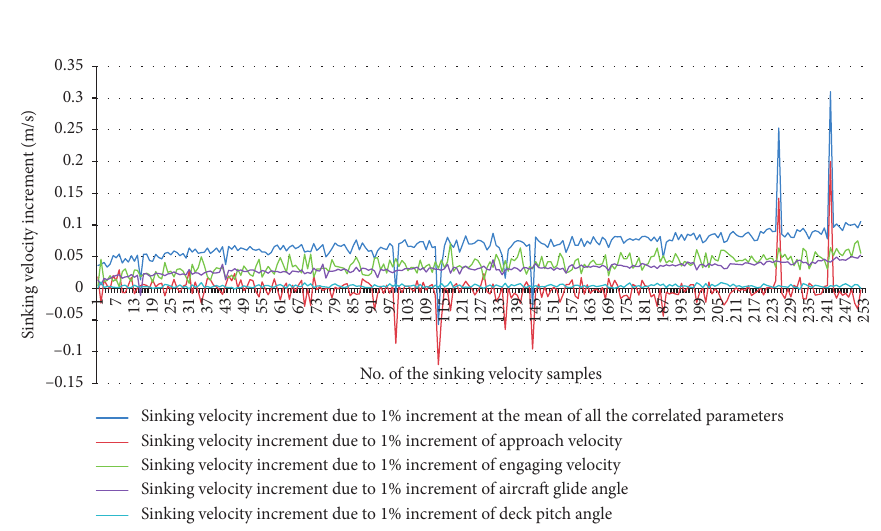
Figure 6: The sinking velocity increment at 1% of the variation of each variable from 252